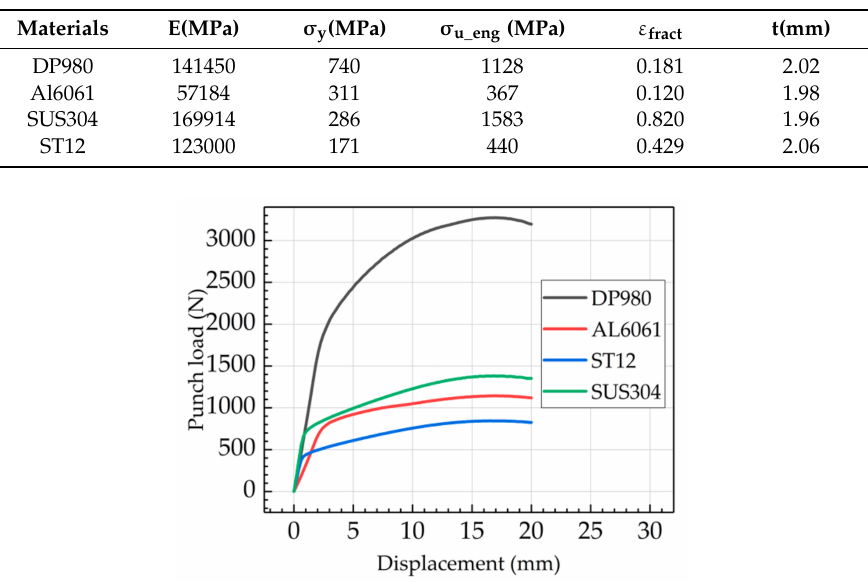
Table 3. Mechanical properties of experimental materials.